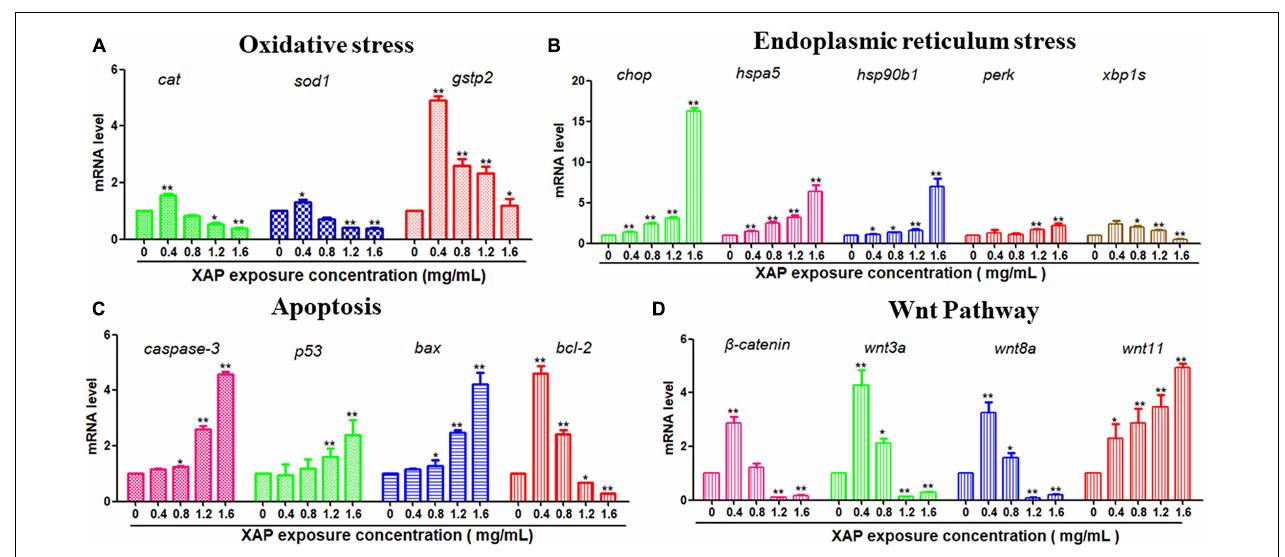
FIGURE 7 | Related gene expression levels of (A) Oxidative stress, (B) Endoplasmic reticulum stress, (C) Apoptosis, and (D) Wnt pathway in zebrafish embryos exposed to XAP at concentrations of 0, 0.4, 0.8, 1.2, and 1.6 mg/mL at 120 hpe. The expression levels of mRNA are represented as the fold change from the control group. ∗ P < 0.05, ∗∗ P < 0.01 versus